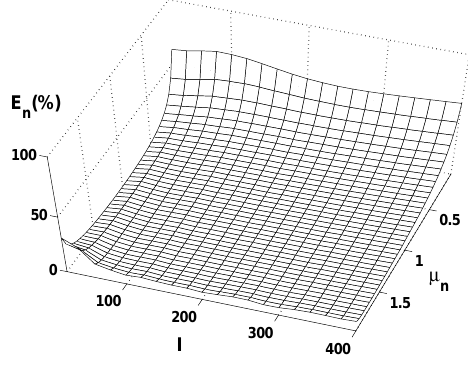
Fig. 13. NLMS global errors E of the identified models, case ( C 3)